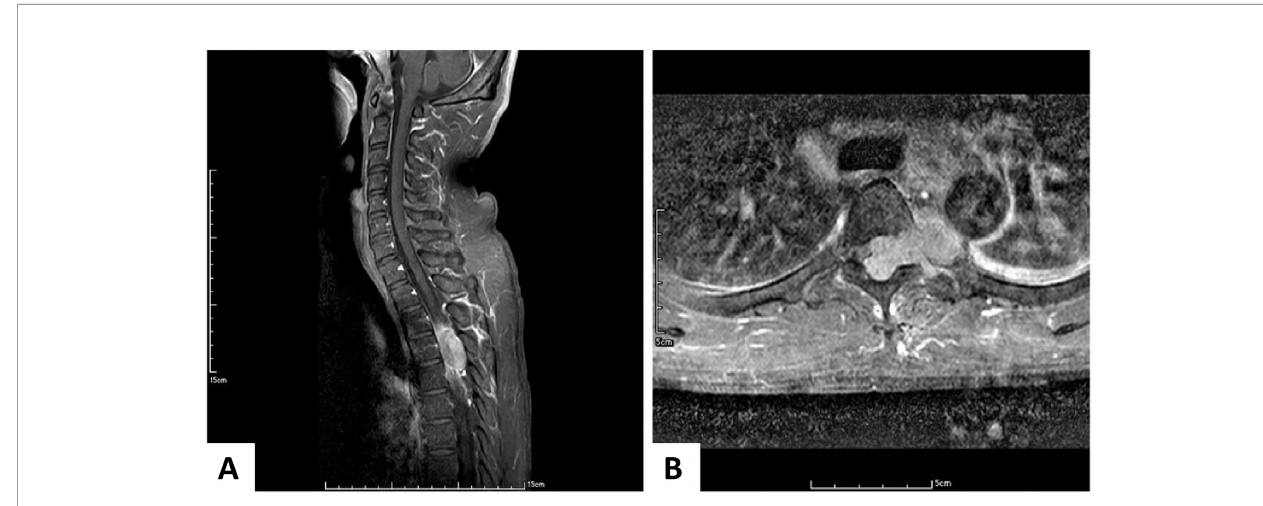
FIGURE 2 | Enhanced Magnetic Resonance Imaging of the Cervicothoracic Spine. (A) In the sagittal view, a large enhancing epidural tumor arising from T4 compresses the spinal cord. (B) In the axial view, this tumor arises from the left neural foramen and pushes the spinal cord to the right. Similarly, the tumor involves the aorta.